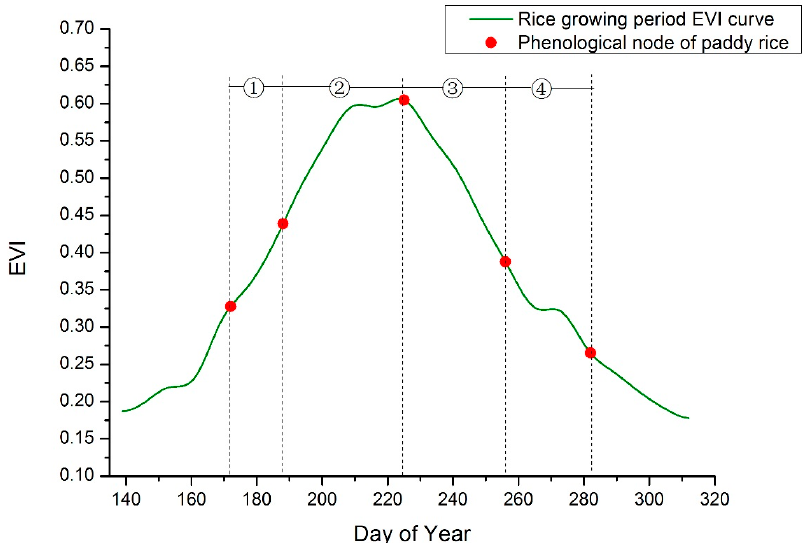
Figure 2. Growing period EVI curve of paddy rice after smoothing by the Savitzky–Golay filter and linear interpolation. The period is divided into four phenology periods. ① to ④ represent the tillering, jointing, heading, and milk-ripe periods, respectively.